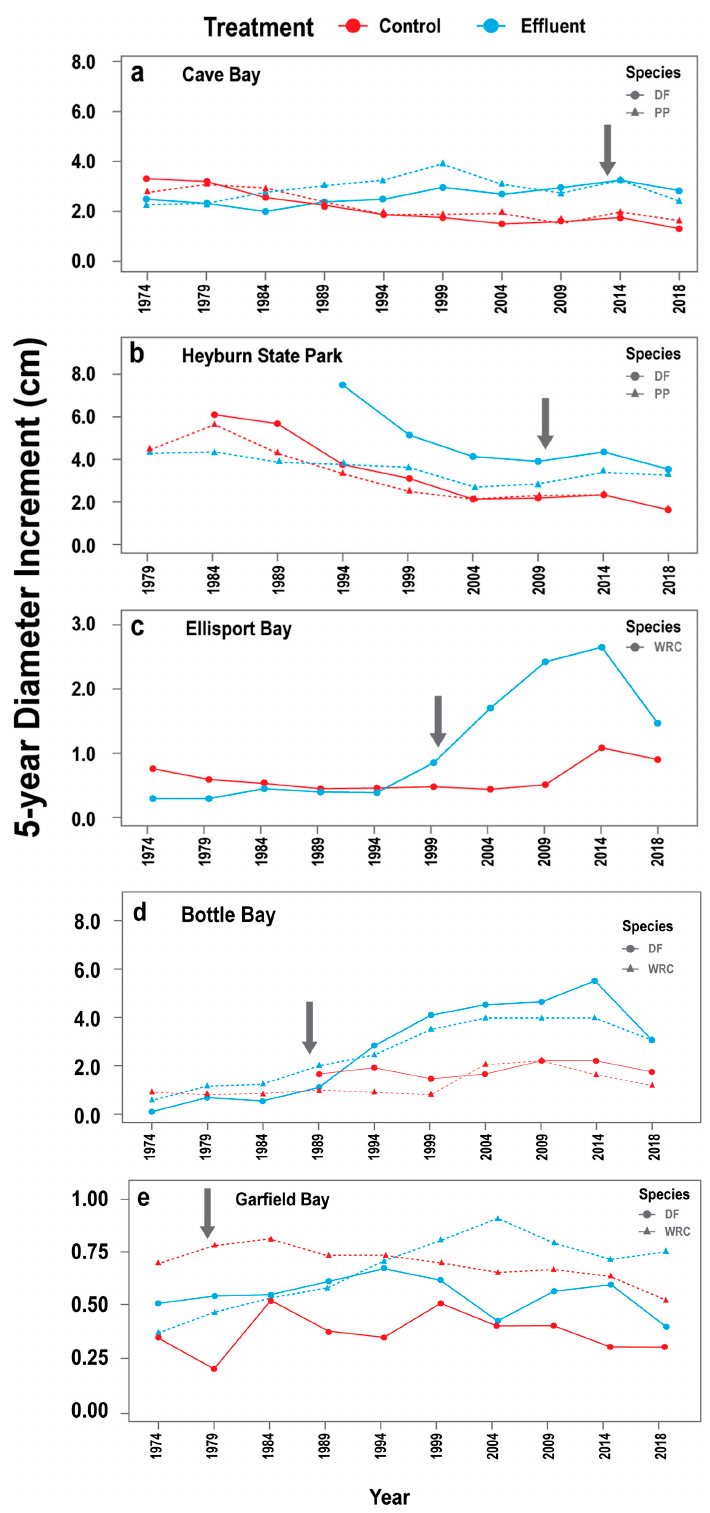
Figure 5. Average five-year diameter increments for ( a ) DF (Douglas-fir)and PP (ponderosa pine) at Cave Bay; ( b ) PP (ponderosa pine) and DF (Douglas-fir) at Heyburn State Park; ( c ) WRC (western redcedar) at Ellisport Bay; ( d ) DF (Douglas-fir) and WRC (western redcedar) at Bottle Bay; and ( e ) DF (Douglas-fir) and WRC (western redcedar) at Garfield Bay. Arrows indicate the start of reclaimed water